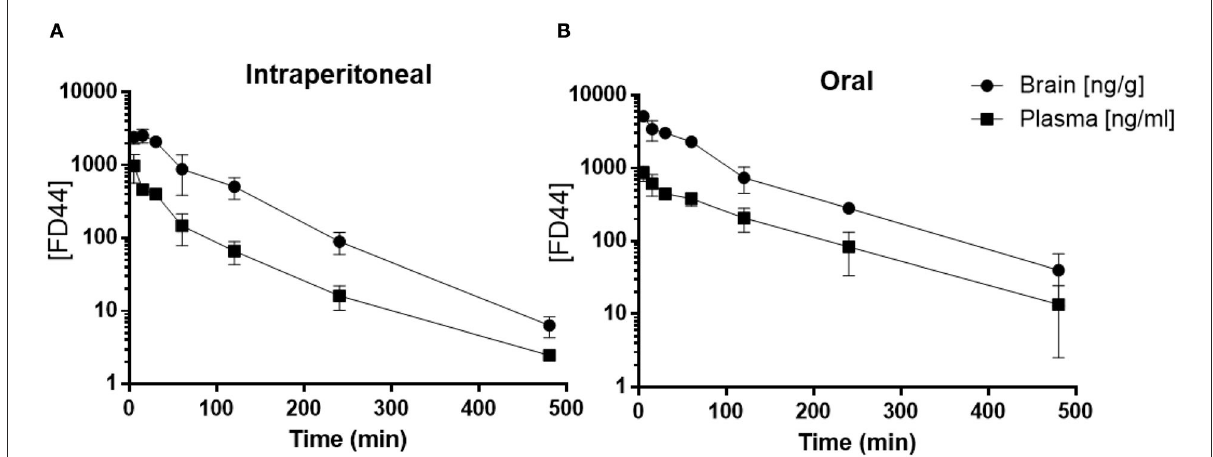
FIGURE2 FD44 pharmacokinetic (PK) profile. (A) Mean ± SD of plasma (square) and brain (circle) FD44 concentration over time (5, 15, 30, 60, 120, 240, and 480min), following FD44 single intraperitoneal administration (dose: 10 mg/kg) or (B) oral administration (dose: 50 mg/kg). The concentration of FD44 [FD44] is presented in a semilogarithmic graph, units in plasma are ng/ml and in brain ng/gr. n = 3 mice per time point.